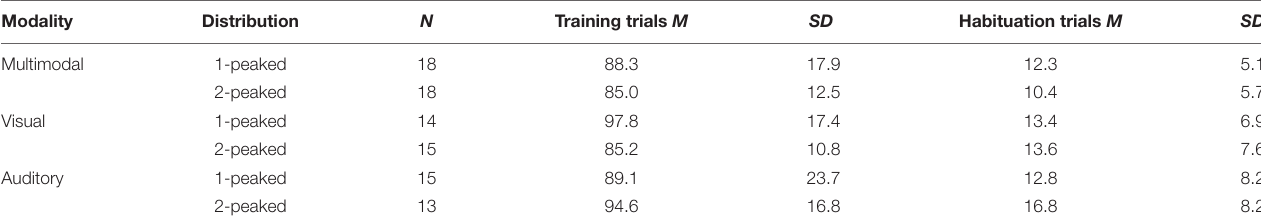
TABLE 1 | Attentional measures for each condition: the average number of trials that infants attended to for at least 500 ms during training, and the average number of trials required to reach habituation.